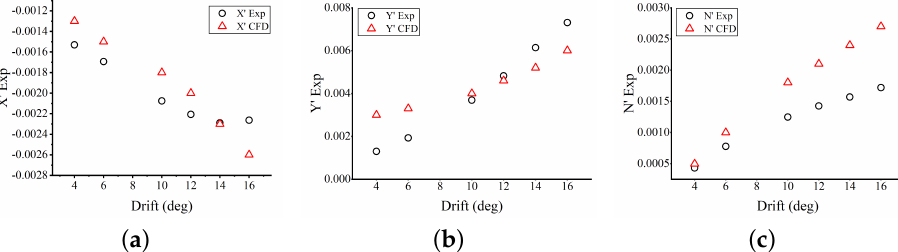
Figure 17. Validation of rotating arm test simulation. ( a ) Comparison of the numerical result X (cid:48) with the reported experimental data; ( b ) comparison of the numerical result Y (cid:48) with the reported experimental data; and ( c ) comparison of the numerical result N (cid:48) with the reported experimental